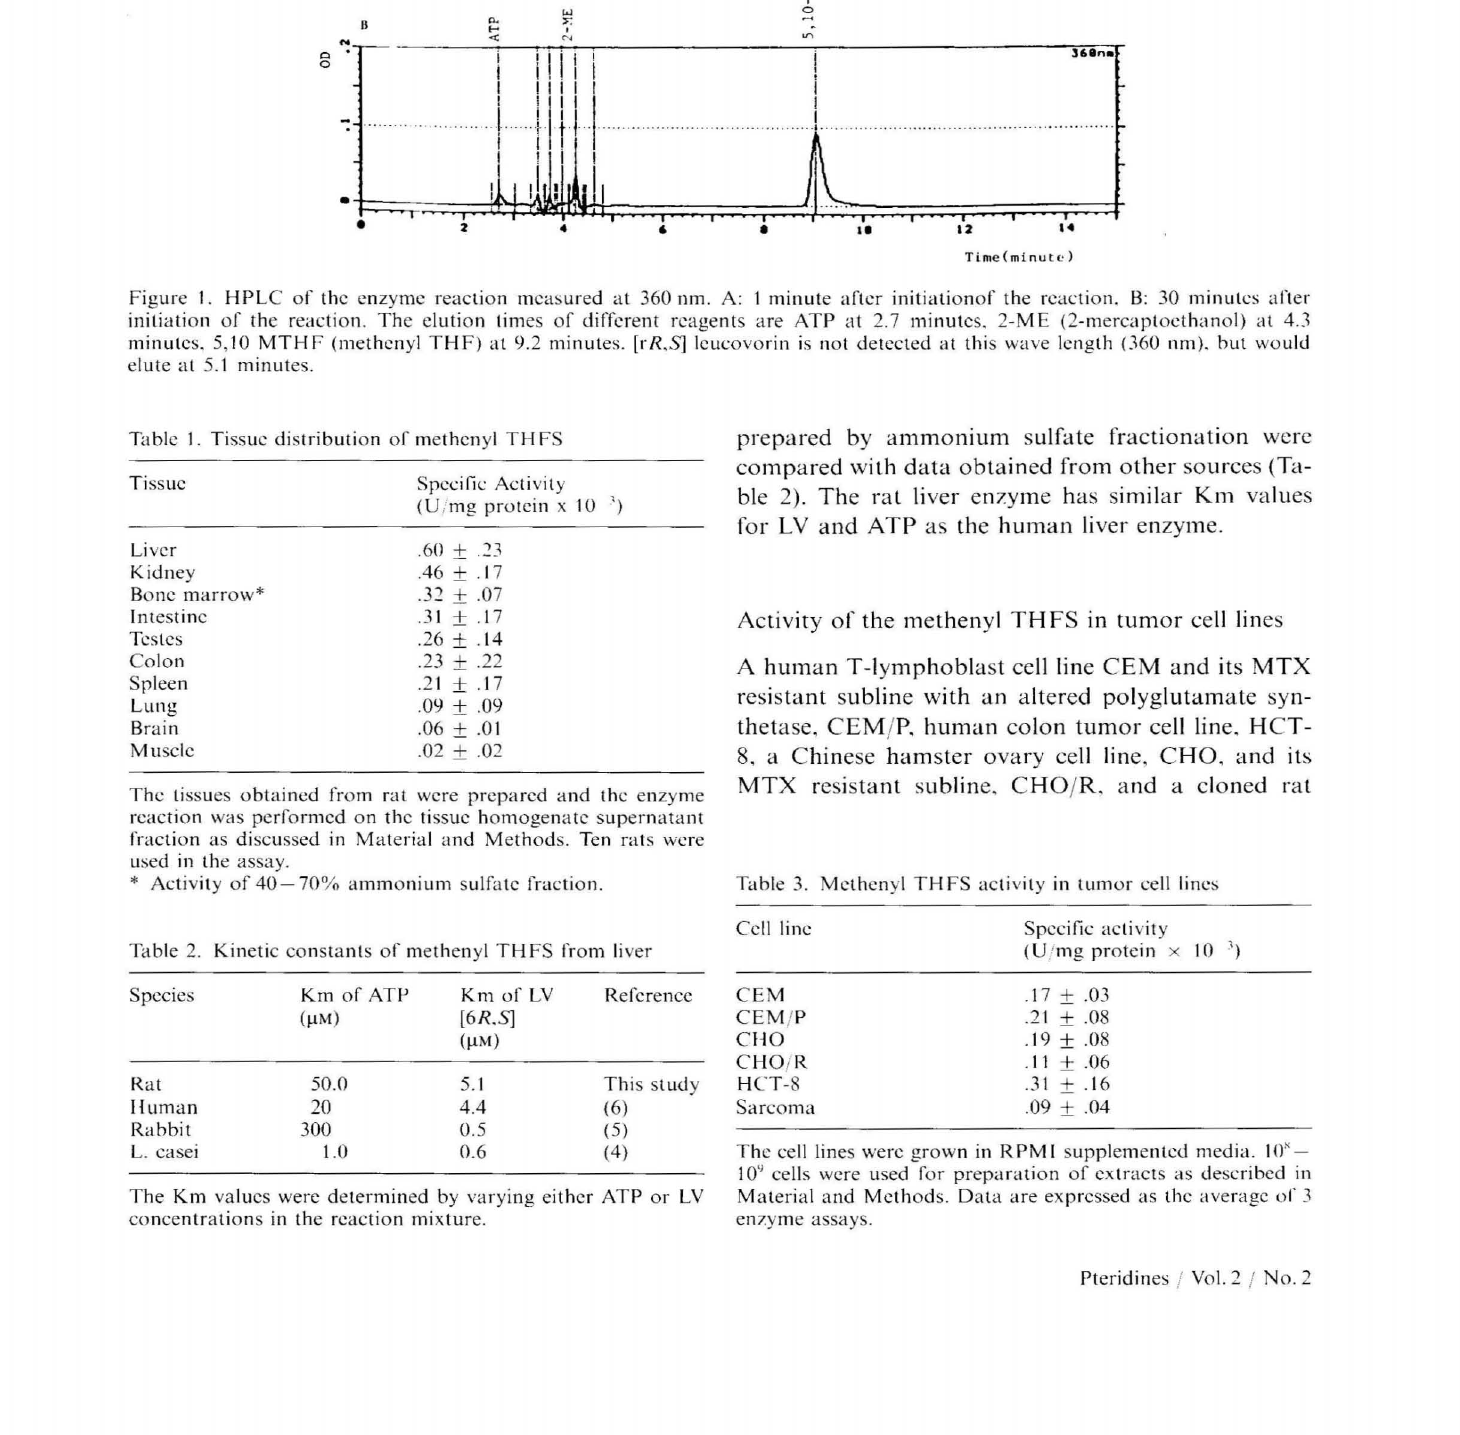
Figure 1. HPLC of the enzyme reaction measured at 360 nm. A: 1 minute after initiationof the reaction. B: 30 minutcs after initiation of the reaction. The elution times of different reagents are ATP at 2.7 minutes. 2-ME (2-mercaptocthanol) at 4.3